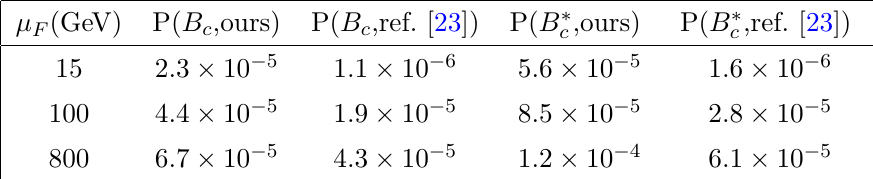
) calculated in c